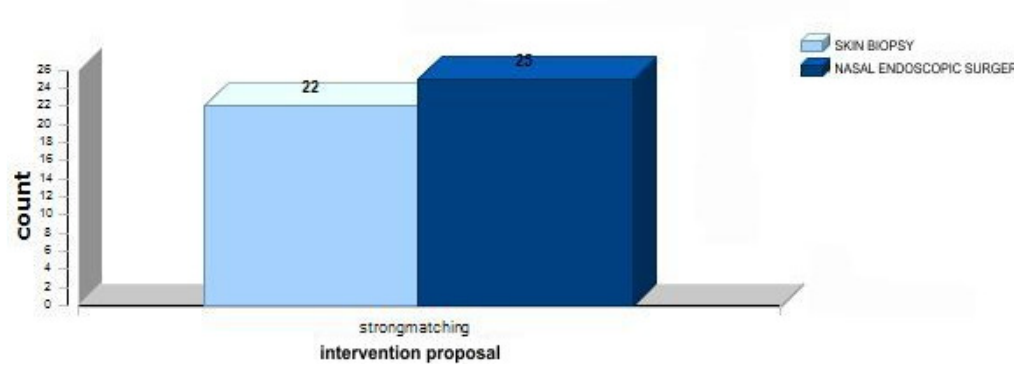
Figure 7: Result for query {(SURGERY,ENDOSCOPY,NASAL),(BIOPSY,SKIN)}